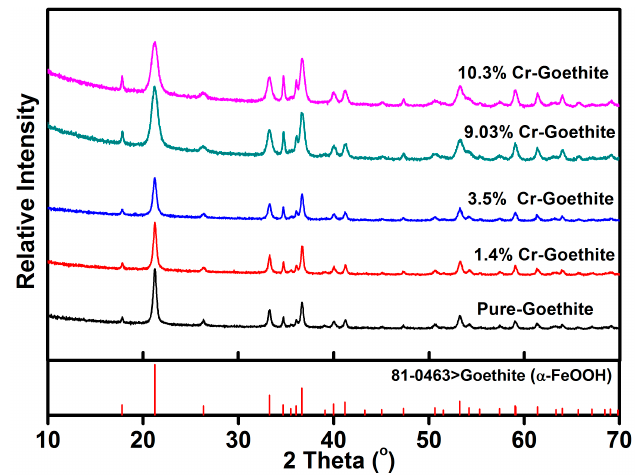
Figure 1. X-ray diffraction (XRD) patterns of the prepared pure goethite and Cr-substituted goethite (Cr-goethite) samples.